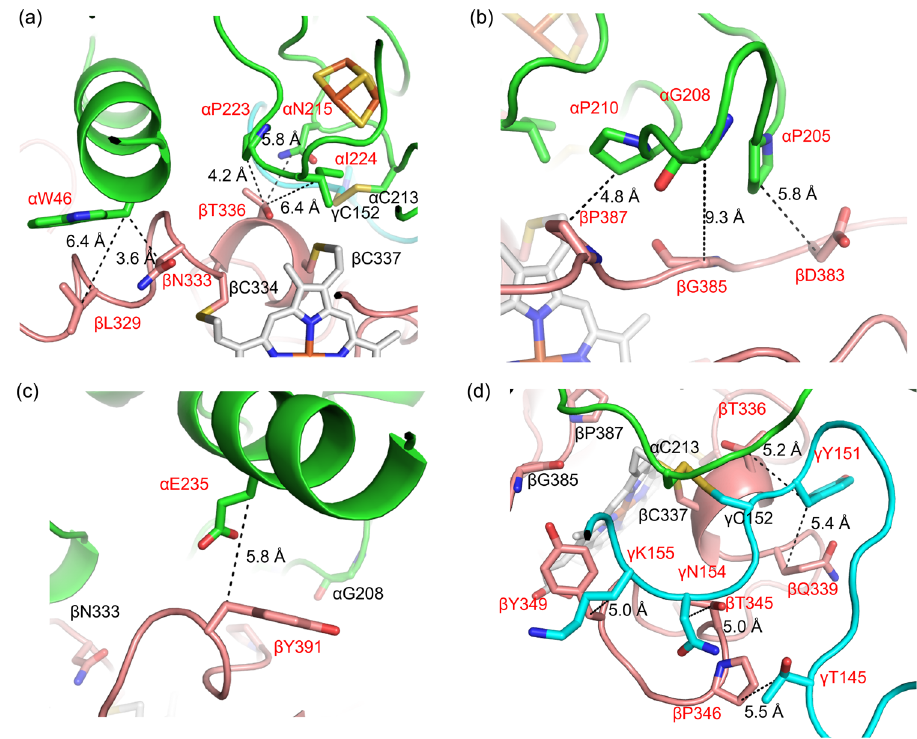
Fig. 2 Designed disul fi de bonds in BcGDH γαβ complex. Dotted lines show the distances of around 5 Å between C β of selected residues with red labels. The colors of cartoon and stick models are the same as presented in Fig. 1a. 9 pairs between catalytic and electron transfer subunits are described in ( a ) to ( c ); a α W46/ β L329 (6.4 Å), α W46/ β N333 (3.6 Å), α N215/ β T336 (5.8 Å), α P223/ β T336 (4.2 Å), α I224/ β T336 (6.4 Å), b α P205/ β D383 (5.8 Å), α G208/ β G385 (C α s; 9.3 Å), α P210/ β P387 (4.8 Å), c α E235/ β Y391 (5.8 Å), 5 pairs between small and electron transfer subunits are described in ( d ); d γ T145/ β P346 (5.5 Å), γ Y151/ β T336 (5.2 Å), γ Y151/ β Q339 (5.4 Å), γ N154/ β T345 (5.0 Å), γ K155/Y349 (5.0 Å).